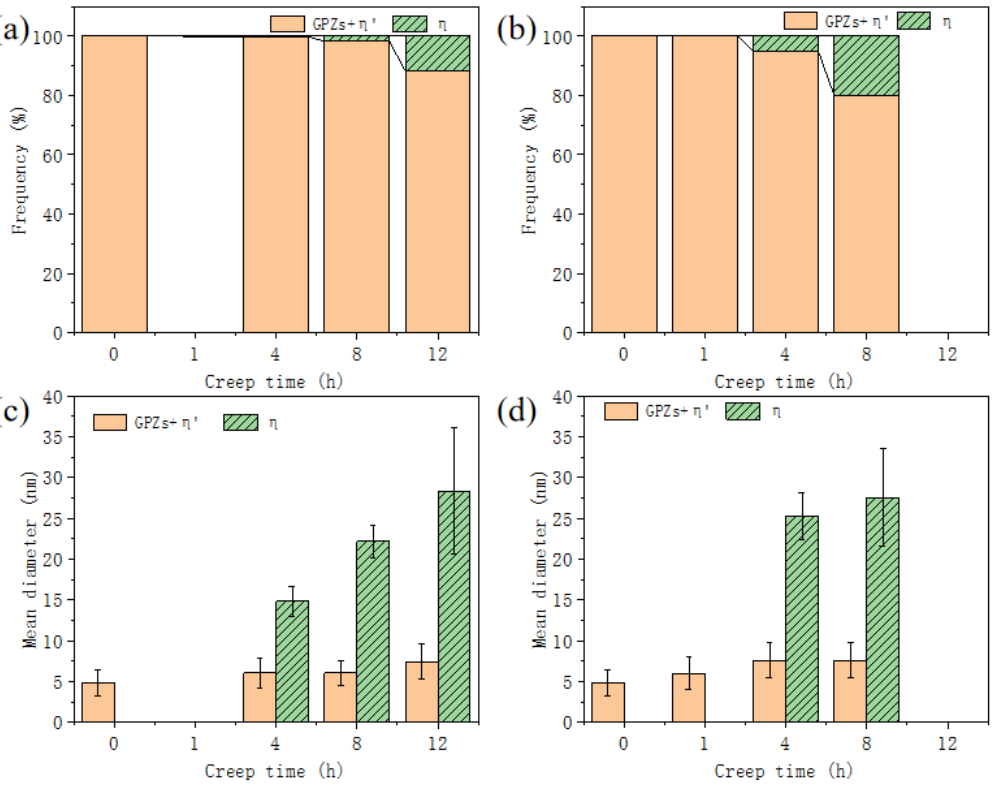
Figure 11. The number frequency and Average diameter of GP zones/η’ precipitates and η precip- itates during creep aging: ( a , c ) at 140 °C; ( b , d ) at 160